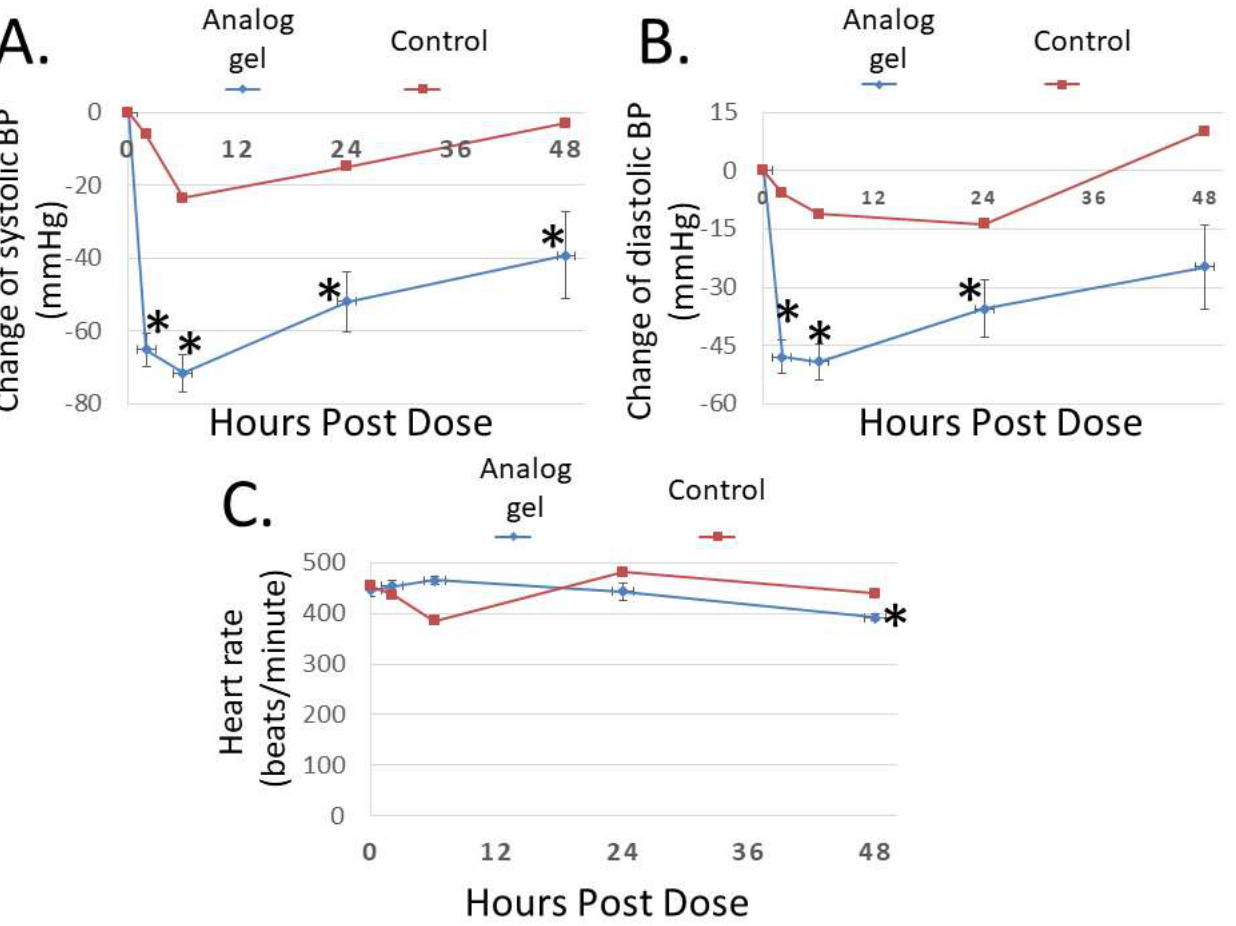
Figure 7. The Analog C-6 gel solution has a prolonged effect on blood pressure in SHR rats. Subcutaneous injection of Analog C-6 gel solution led to the significant reduction of ( A ) systolic blood pressure at 2, 6, 24, and 48 h after administration and ( B ) diastolic blood pressure at 2, 6, and 24 h after administration in male SHR rats (8%; 8 mg/100 µL injection). On the other hand, Analog C-6 gel injection only affected ( C ) the heart rate 48 h after injection. The hemodynamics was recorded on 0, 2, 6, 24, and 48 h after drug administration. Data are mean ± SEM of five separate animals. In addition, the change of hemodynamics of a representative control animal, which received saline injection, is included for comparison (red lines) *, Significantly different from the measurement at 0 h. In addition to the analysis of systemic effect, we studied the local effect of Analog C-6 gel solution on dermal blood flow in the hindlimbs of adult rats (Figure 8A–C). Subcuta- neous injection of Analog C-6 gel solution (8%; 8 mg/100 µ L solution) in the left hindlimb (i.e., treatment side) led to a sustained and significant increase of dermal blood flow in the left hindlimb at 1–72 h after injection. Although Analog C-6 gel administration also increased dermal blood flow in the right hindlimb (control side) at 2 and 6 h after drug administration, this increase disappeared 24 h after injection. The increase in dermal blood flow within the left hindlimb was significantly higher than that of the right hindlimb at 2, 4, 6, 24, and 48 h after administration, suggesting the gel solution has a prolonged local effect on vasodilation (Figure